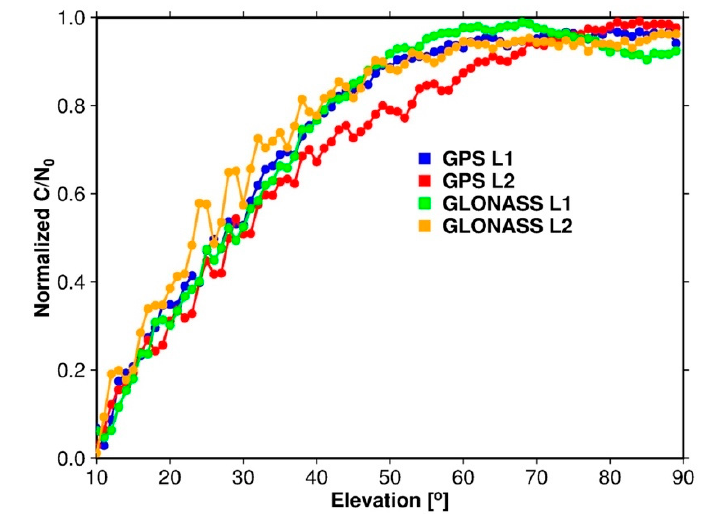
Figure 8. The normalized SNR time series for SHM5.